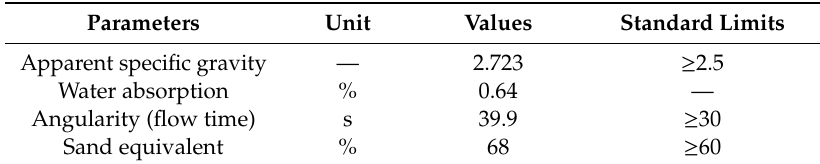
Table 3. Technical properties of fine aggregate.